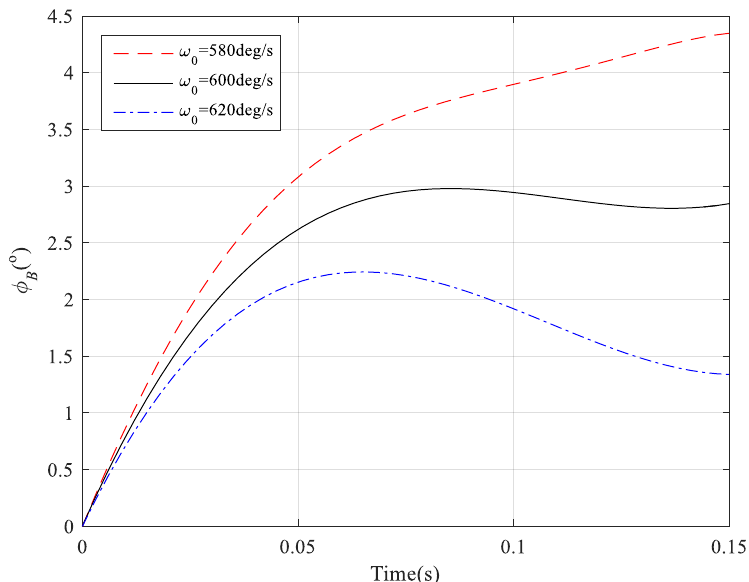
Figure 21. Simulation results for pitching adjustment under different angular speeds of forelimbs.